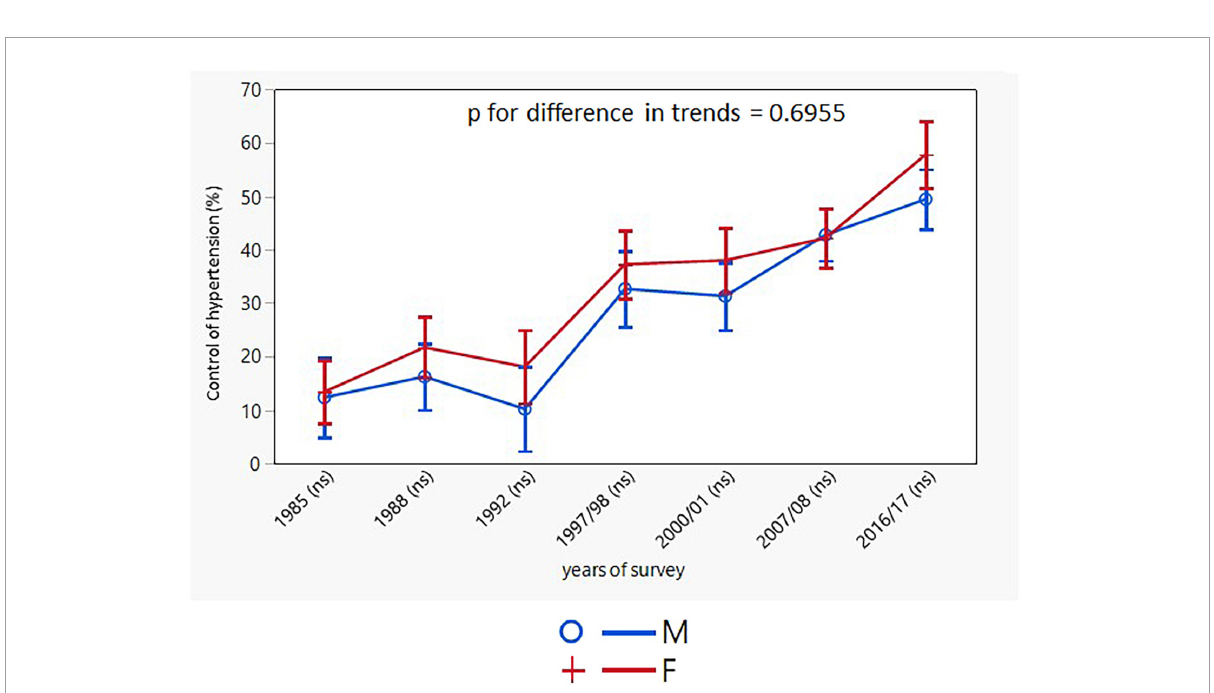
FIGURE8 Age-adjusted trends in control of hypertension in drug treated hypertensives (95% confidence interval). M, males; F, females; p for differences in trends between males and females. NS indicates in brackets after survey years the sex differences in respective surveys after Bonferroni